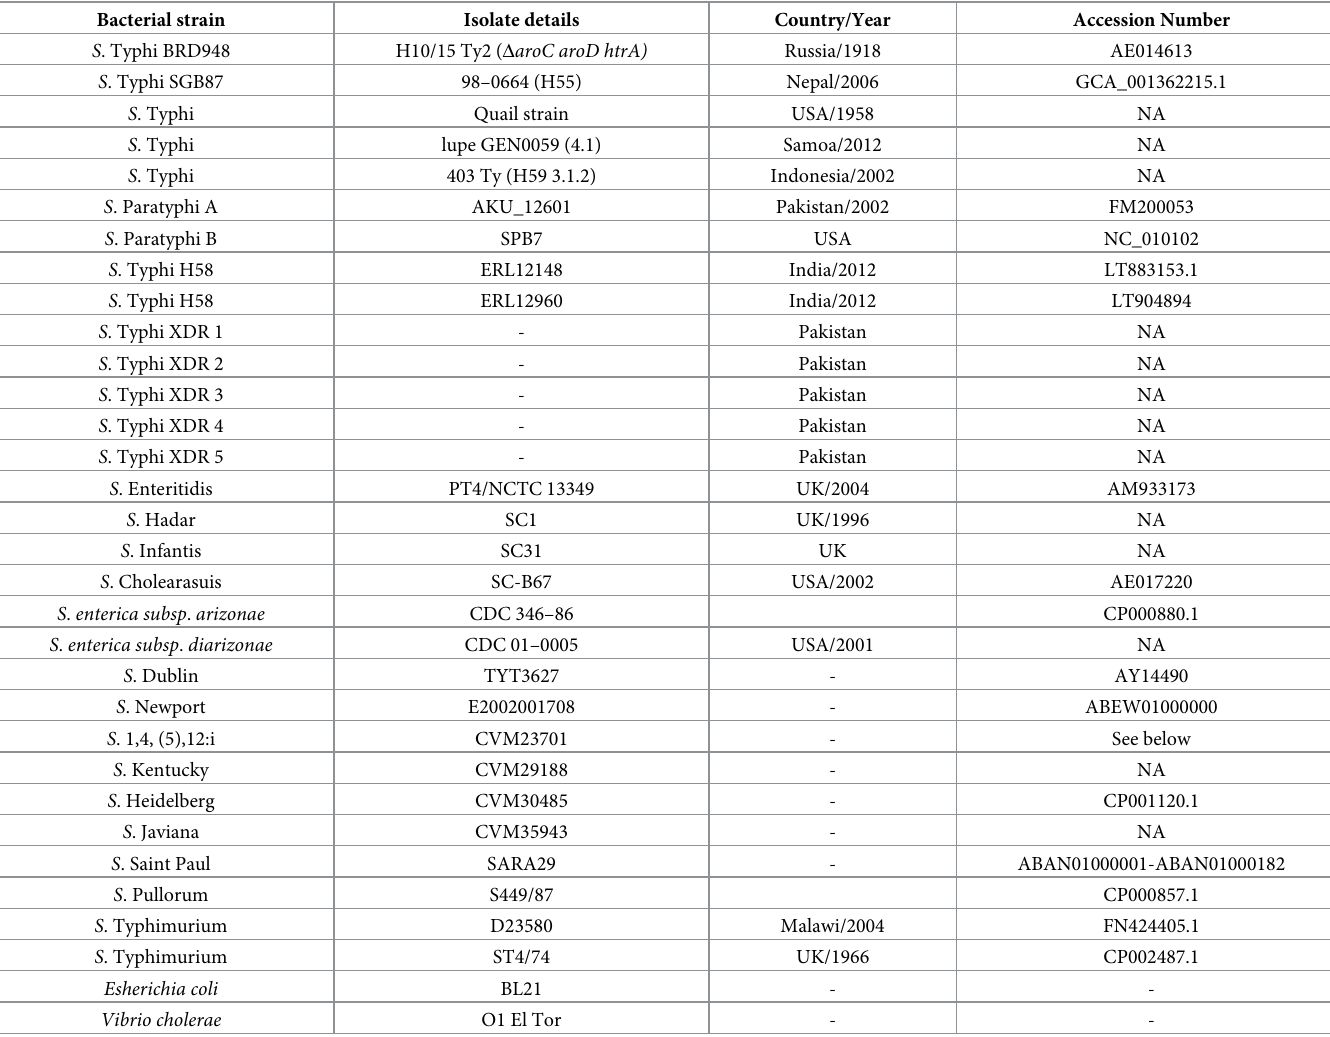
Table 1. Bacterial DNA strains used in testing. All Salmonella strains are serovars of subspecies enterica unless otherwise stated. Bacterial